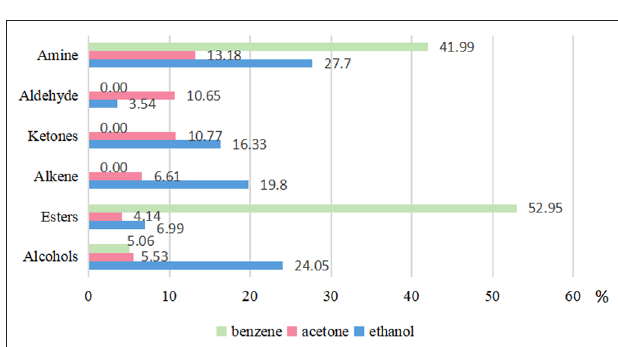
FIGURE 3 | Content percentage of three solvents from C. camphora